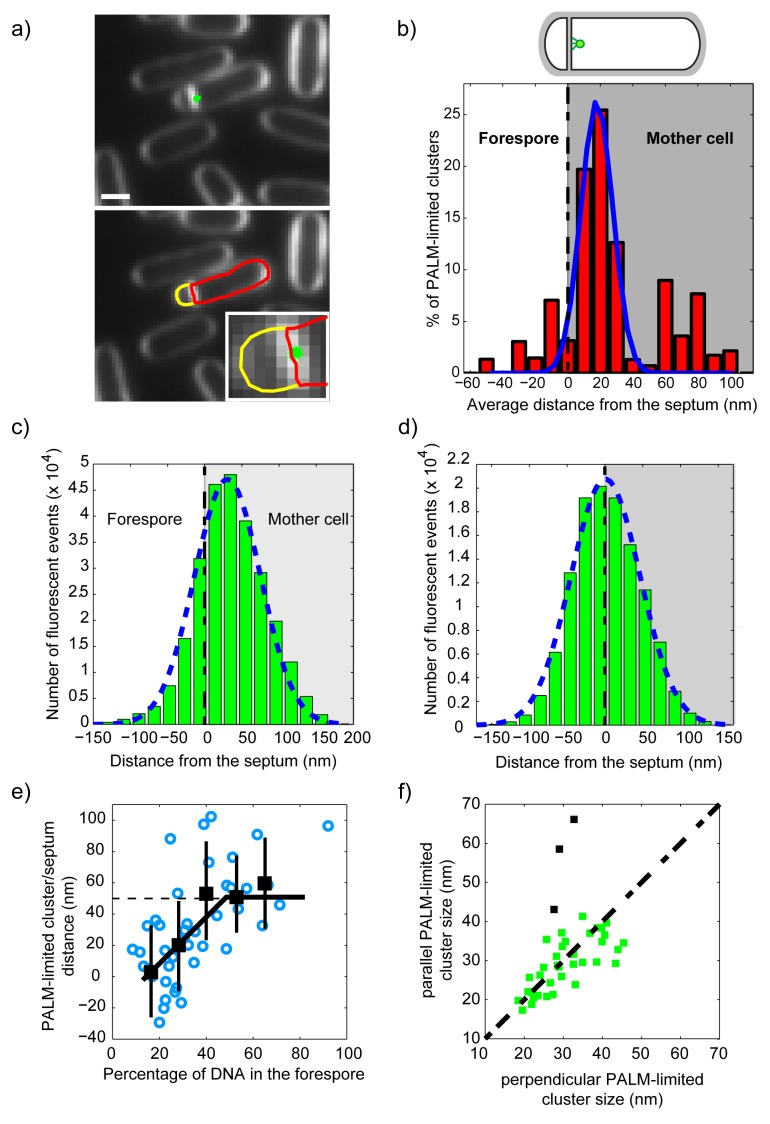
SpoIIIE clusters assemble asymmetrically in sporulation septa.(a) PALM imaging of SpoIIIE (green dots) in sporulating cells overlaid with an epi-fluorescence image of the membrane (white, top panel). Intensity profiles across the direction perpendicular to the septum were used to determine the precise localization of the septal plane, which was used to calculate the distance of each single-molecule detection to the center of the septum and to automatically partition the cell into forespore (yellow) and mother cell (red). Using this partition, individual PALM-limited clusters and single-molecule events were classified as belonging to the mother cell or the forespore compartments. (b) Histogram of PALM-limited cluster localizations with respect to the center of the septum (red columns) in sporulating cells with flat septa and undergoing DNA translocation (N = 43). Black dotted line indicates the position of the septum. A Gaussian distribution was fitted to the data (blue solid line). SpoIIIE PALM-limited clusters preferentially localize on the mother cell side of the sporulation septum. (c) Histogram of single-molecule localizations in PALM-limited clusters (N = 43) in sporulating cells undergoing DNA translocation, and Gaussian fit (blue dotted line). In sporulating cells, the distribution of SpoIIIE with respect to the septum is asymmetric and biased towards the direction of the mother cell. (d) Histogram of localizations of single molecules in PALM-limited clusters of dividing cells (N = 71) and Gaussian fit (blue dashed line). During division, the distribution of SpoIIIE with respect to the septum is symmetric and unbiased. (e) Distance of SpoIIIE PALM-limited clusters to the center of asymmetric septa versus the amount of translocated DNA. Open blue circles represent individual distance values for individual clusters, and black squares the average distance for all clusters detected at each particular percentage of DNA translocated. The relative distance increases linearly with the amount of DNA in the forespore until ∼45% of DNA translocated, and thereon remains constant at ∼50 nm. Solid black line is a guide to the eye. (f) The size (FWHM) of individual PALM-limited clusters in the directions parallel or perpendicular to the asymmetric septa were calculated and plotted against each other to evaluate cluster symmetry (squares). The overwhelming majority of clusters are symmetric (green squares) with only a small minority being longer in the direction parallel to the septum (black squares). The dotted line is a guide to the eye.